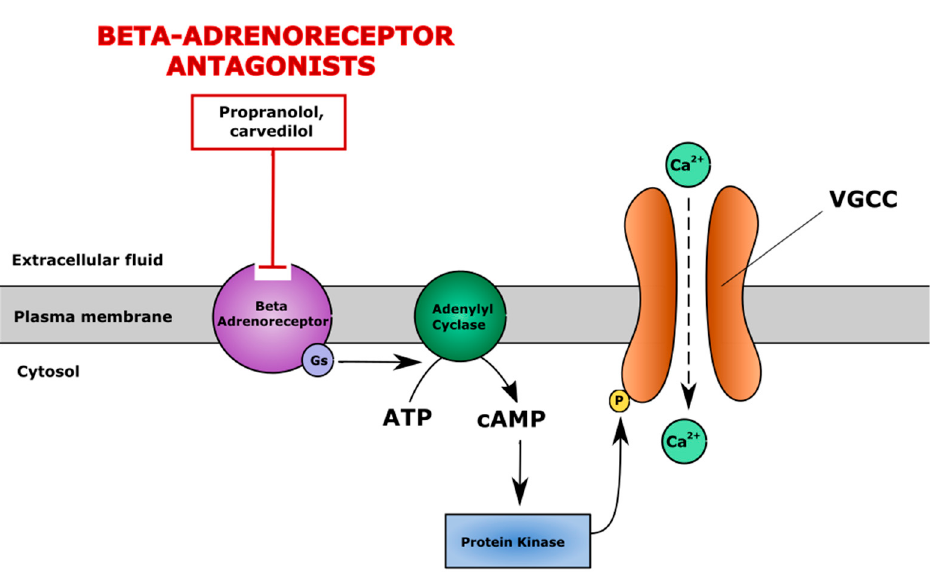
Figure 6. The mechanism of action of β -adrenergic system antagonists. β -adrenergic system antag- onists (e.g., propranolol, carvedilol) block β -adrenoreceptors and suppress cAMP/PKA pathway- induced activation of voltage gated calcium channels (VGCC), maintaining a physiological level of iCa 2+ . cAMP—cyclic adenosine monophosphate, PKA—protein kinase A.